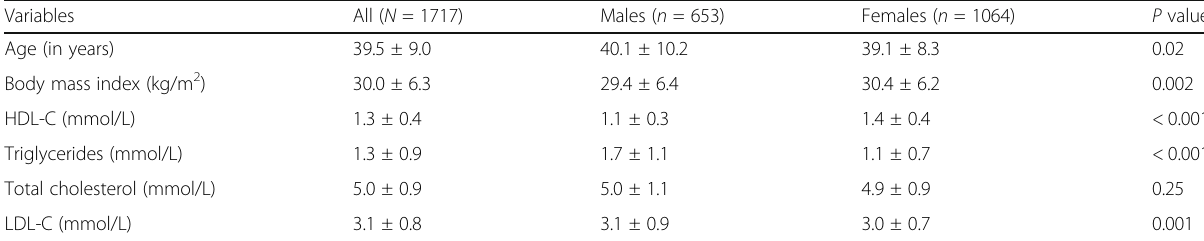
Table 1 Mean (±SD) values for lipid panel in healthy Saudi male and female participants in Riyadh, Saudi Arabia